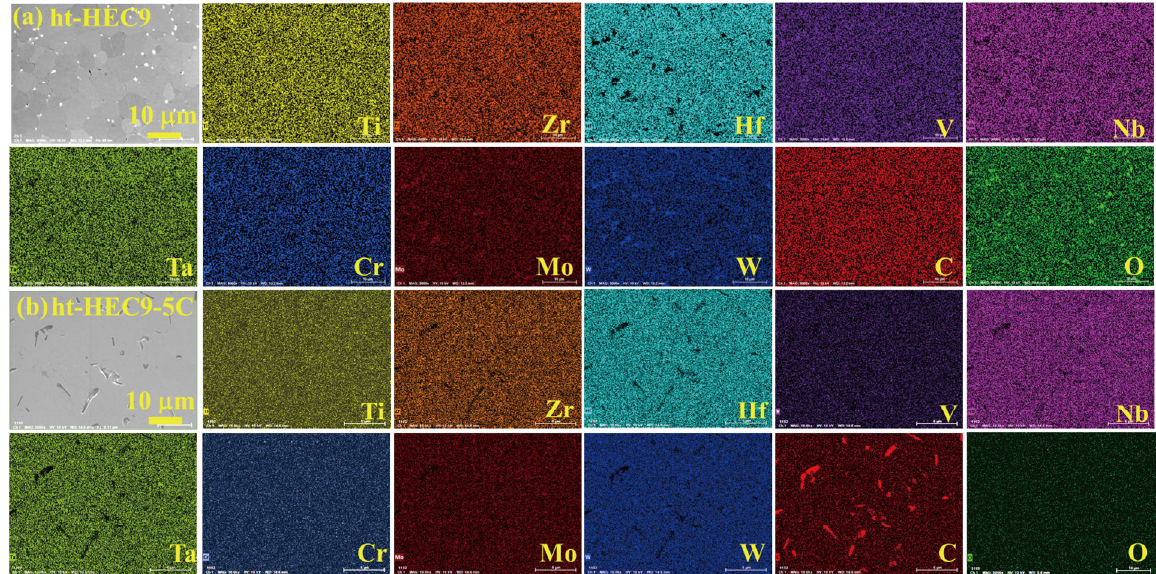
Fig. 4 EDS mappings of the (a) ht-HEC9 and (b) ht-HEC9-5C